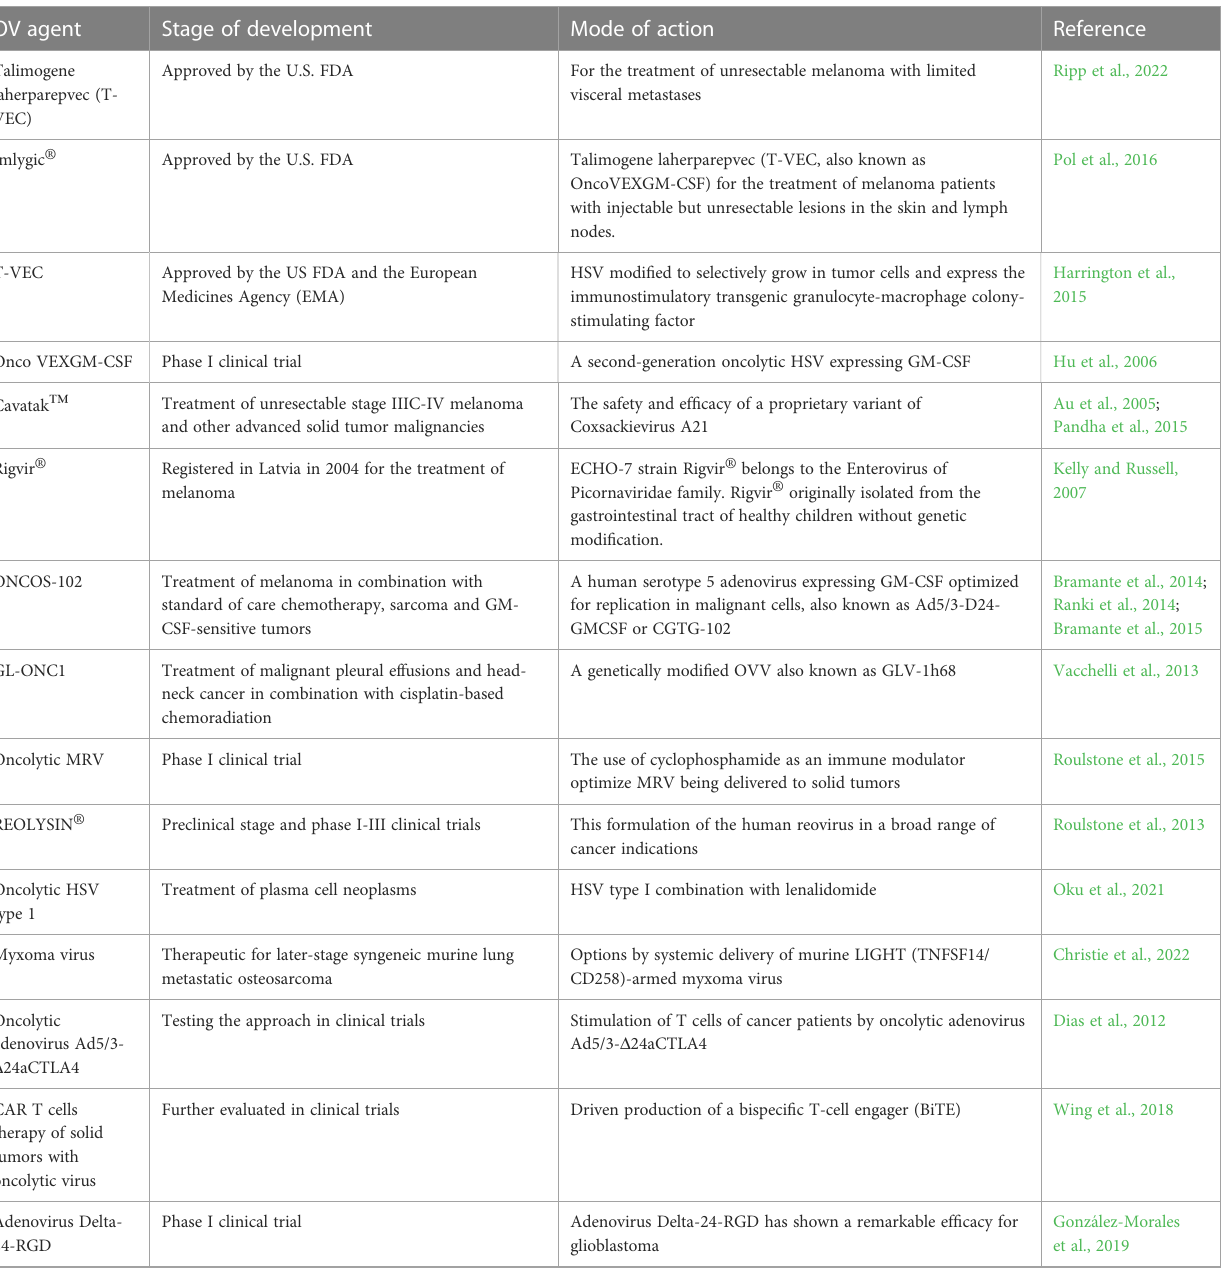
TABLE 1 Clinical trials in this mini